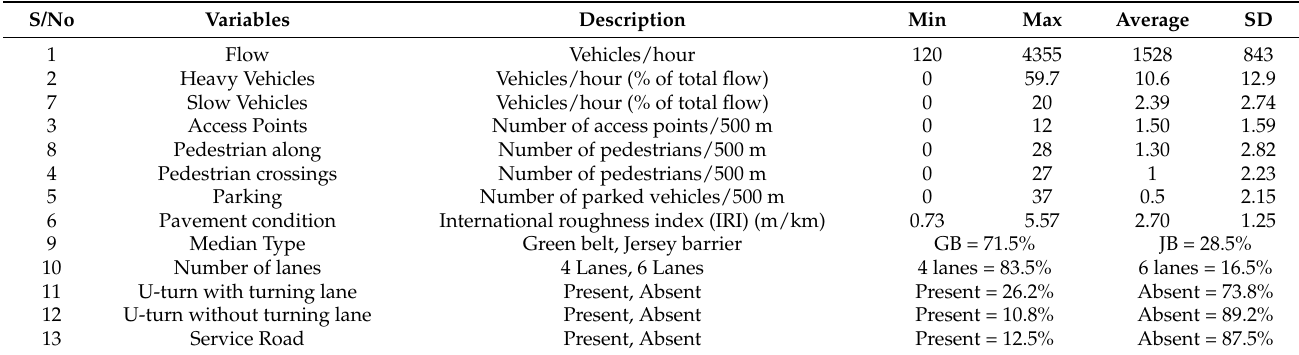
Table 4. Description of Independent